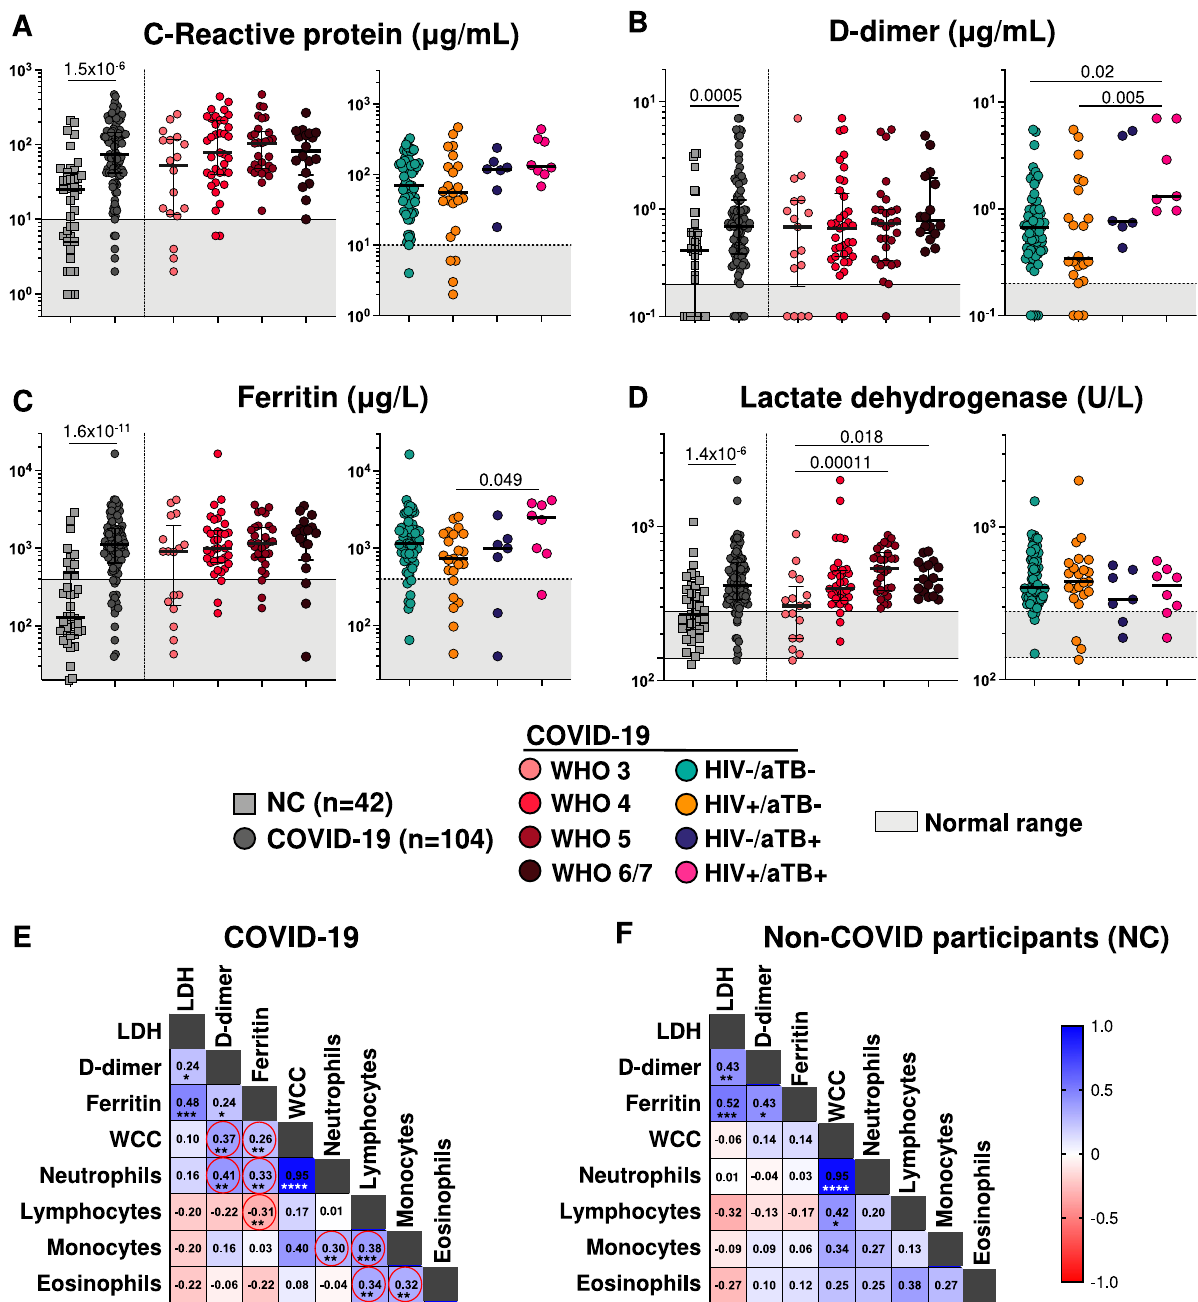
Fig. 3 | Serum biomarkers in relation to disease status and severity, and cor- relation between those markers and peripheral cell counts. A – C C-Reactive protein (CRP), D-dimerand ferritinlevels showed similartrendsbeing signi fi cantly higher in COVID-19 patients than NC. There was no signi fi cant trend in relation to severity of COVID-19 disease. HIV-1 infected patients with both COVID-19 and tuberculosishadhigherlevels of allthreemarkersthanthose withCOVID-19alone. Comparisons between the NC and COVID-19 groups were performed using a Mann Whitney test and other comparisons were performed using a Kruskal-Wallis test. D Lactate dehydrogenase was signi fi cantly higher in COVID-19 patients than NC, withlevelstendingtoincreasewithincreasingCOVID-19diseaseseverity.Therewas however no relationship with HIV-1 and/or tuberculosis status. Comparisons